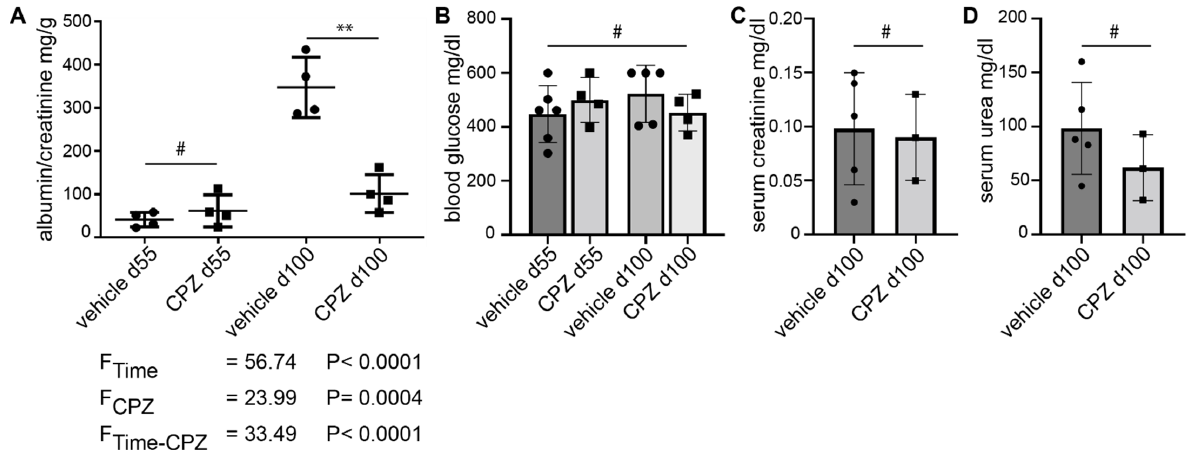
Figure 6. Daily administration of capsazepine over 45 days reduces albuminuria in type 1 diabetic AKITA mice. ( A ) At 55 days of age, AKITA mice do not show significant albuminuria. After 45 days of treatment (100 days of age), the albumin/creatinine ratio is reduced in capsazepine-treated AKITA mice (black squares) as compared to vehicle-treated littermates (black dots) ** p -value < 0.01; # not significant (ns)). 2-way ANOVA shows clear differences of means for age (F Time ) and capsazepine treatment ( F CPZ ) and a clear interaction effect of both categorical variables (F Time-CPZ ). ( B ) Blood glucose levels are elevated but are not affected by CPZ-treatment (means: 448.00 mg/dL vehicle d55; 500.25 mg/dL CPZ d55; 522.80 mg/dL vehicle d100; 453.25 mg/dL CPZ d100; # = ns). ( C , D ) Serum creatinine and serum urea levels show no significant differences between treatment groups at study termination (creatinine means: 0.098 mg/dL vehicle; 0.090 mg/dl CPZ; urea means: 98.4 mg/dL vehicle; 62.0 mg/dL CPZ; # =